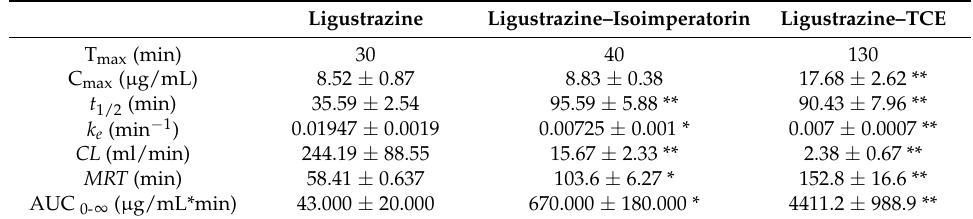
Table 2. Pharmacokinetic parameters of ligustrazine after solely or co-administration with TCE (or isoimperatorin) in rats ( n = 10).